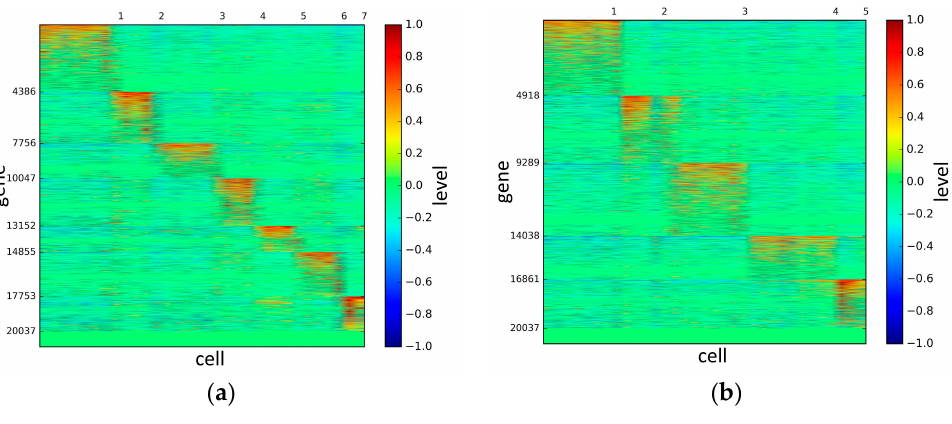
Figure 9. The heat maps of Ramskold datasets. Figure 9 . The heat maps of Ramskold datasets. Table 4. The number of clusters in the ‘gold standard’ and four